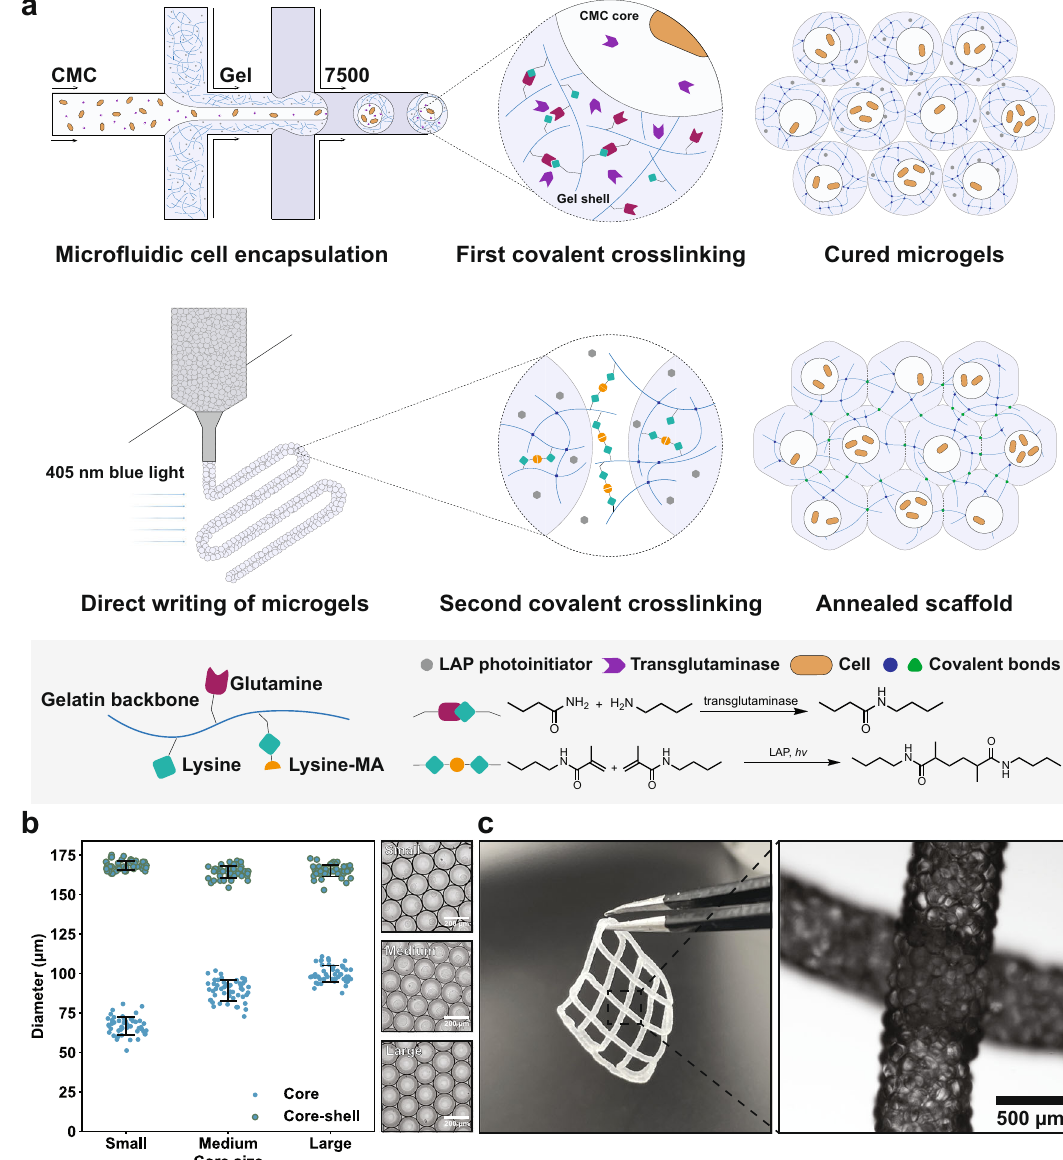
Fig. 1 | Micro fl uidic templating of core-shell microgel building blocks for fab- ricating PAM scaffolds. a Schematic of the formation of PAM scaffolds. First, the LAP-containing gelatin/gelMA polymer blend, together with cell-containing CMC solution spiked with transglutaminases, is emulsi fi ed by carrier oil into droplets within a fl ow-focusing micro fl uidic device. Droplets are then converted into microgelsbyenzymaticreactions,afterwhichtheyareextrudedandpatternedinto scaffolds.Finally,bluelightinitiatesasecondcovalentcrosslinkingamongjammed microgels, giving rise to PAM scaffolds. b By micro fl uidics, the core-shell ratio can